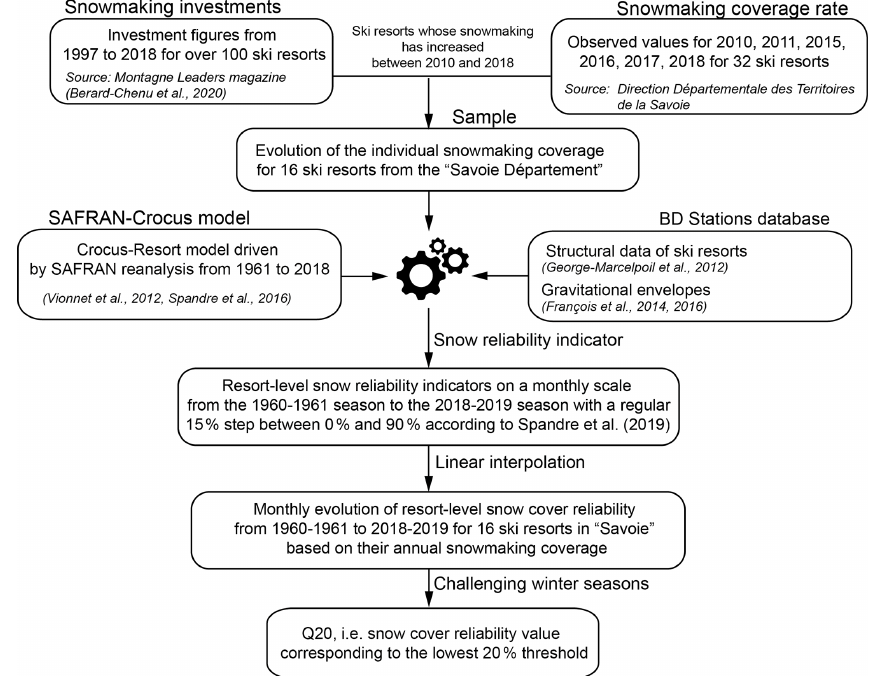
Figure 1. Schematic description of the methods implemented in this study.